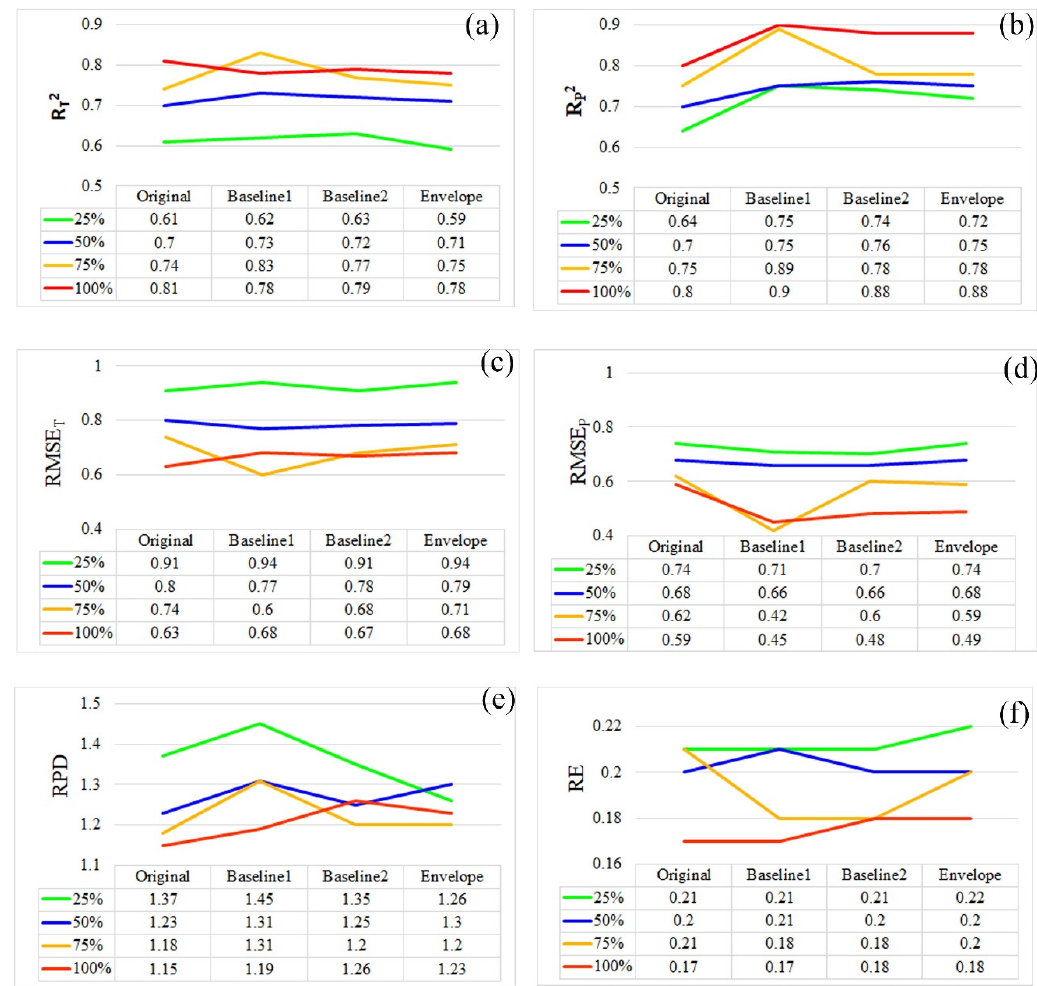
Figure 4. Model robustness evaluation analysis. ( a ) R T2 , ( b ) R P2, ( c ) RMSE T , ( d ) RMSE P , ( e ) RPD and ( f ) RE. In the figure, Baseline1 is a 500–750 nm baseline, and Baseline2 is a 750 nm baseline.